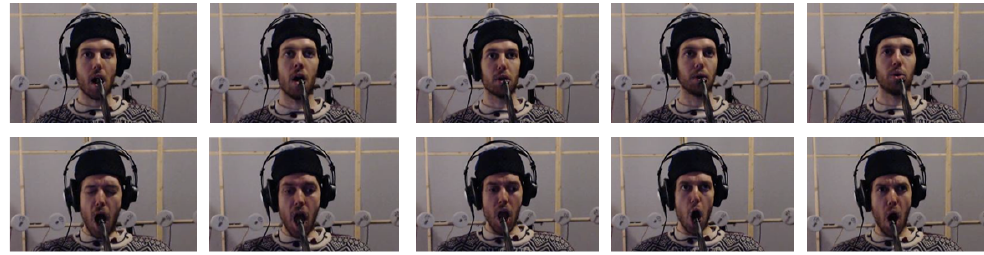
Figure 6. Exemplary mouth openings extracted from video for one male singer for the vowels /a:/, /e:/, /i:/, /o:/, /u:/ (left to right) at c/C3/131 Hz in the top row and a 2 /A4/440 Hz in the bottom row.